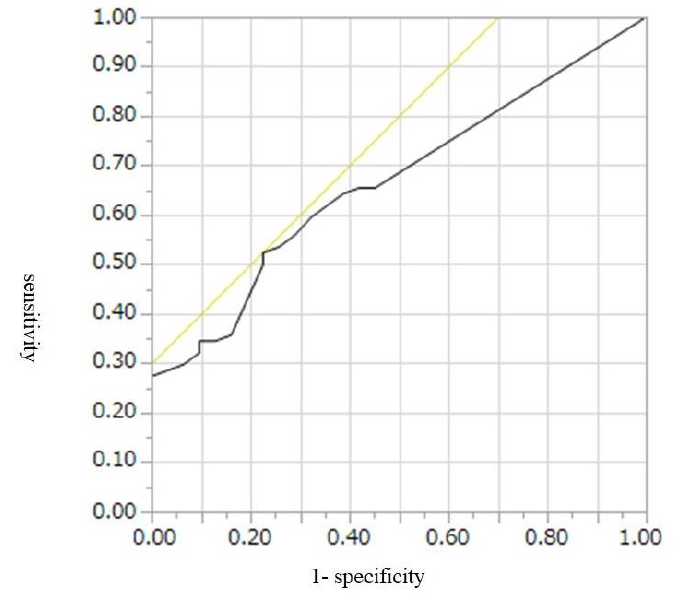
Figure 2. Receiver operating characteristics curve of the presence of mural lesions on contrast-enhanced CT for the diagnosis of malignant IPMN. CT, computed tomography; IPMN, intraductal papillary mucinous neoplasm.